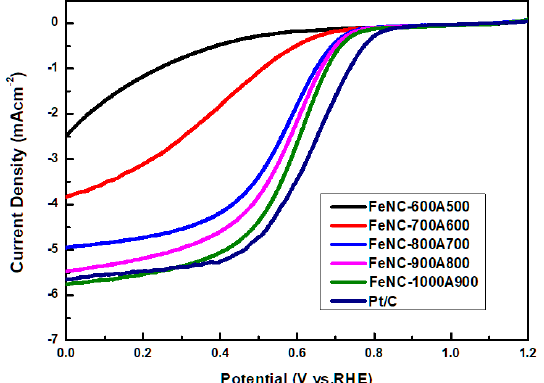
Figure 10. LSV curves obtained from an O 2 -saturated 0.1 M HClO 4 aqueous solution at a scanning rate of 5 mV/s and a rotation rate of 1600 rpm for FeNCs prepared with different calcination methods.